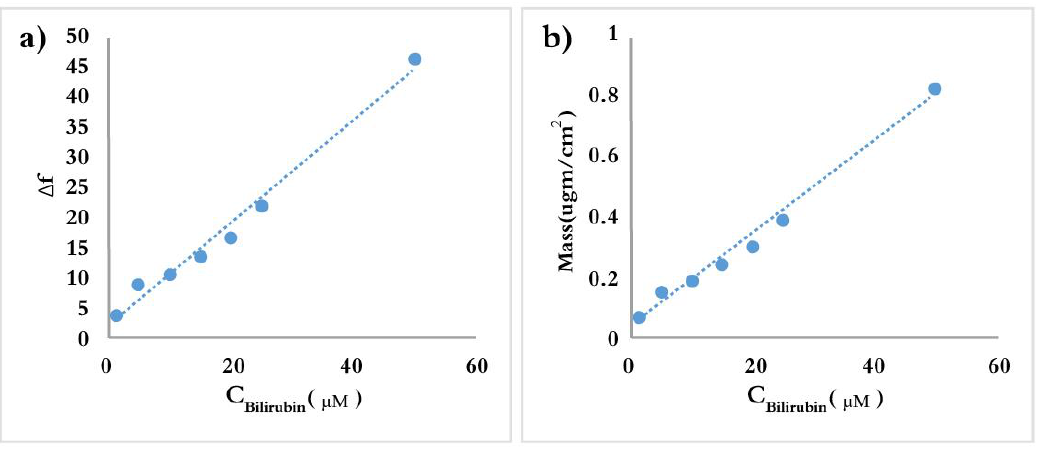
Figure 5. Linearity of QCM sensors for aqueous bilirubin solutions at a concentration range 1.71–85.51 µM, ( a ) ∆f versus C Bilirubin ; ( b ) mass versus C Bilirubin .